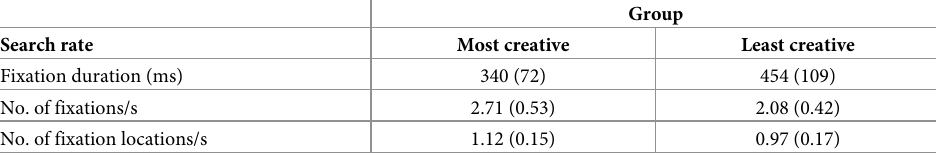
Table 2. Mean (SD) fixation duration and number of fixations and fixation locations (per second) across groups.